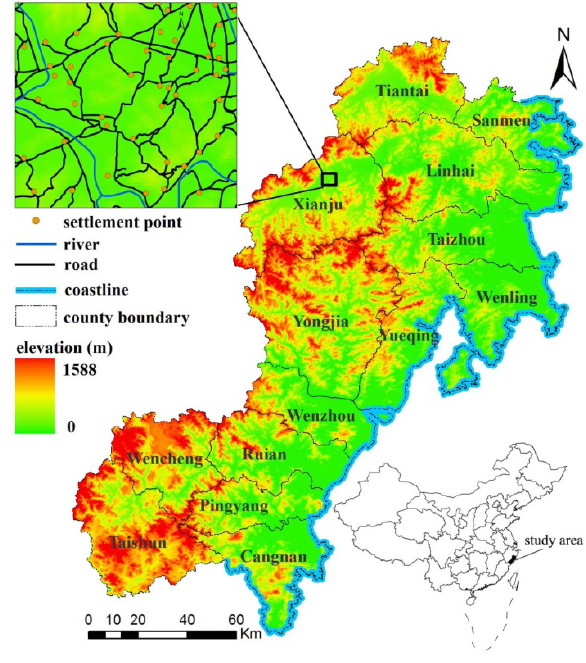
Figure 1. Location of the Wen-Tai region, Zhejiang Province,